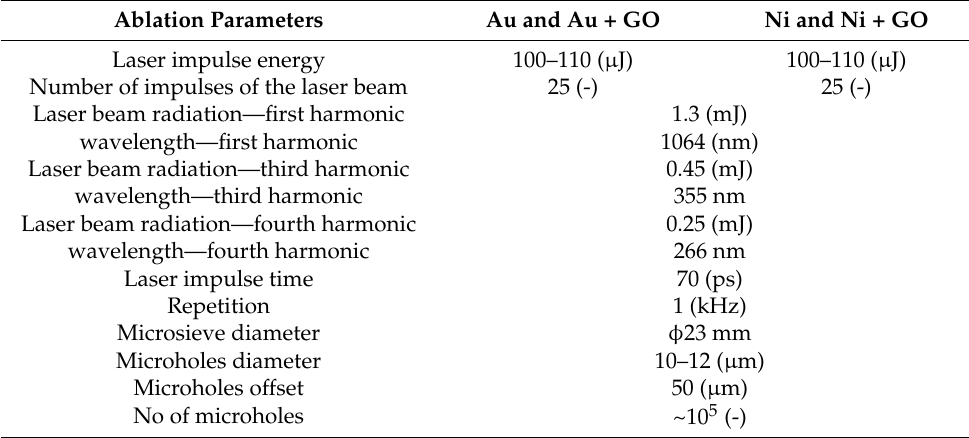
Table 1. Parameters used in microsieve